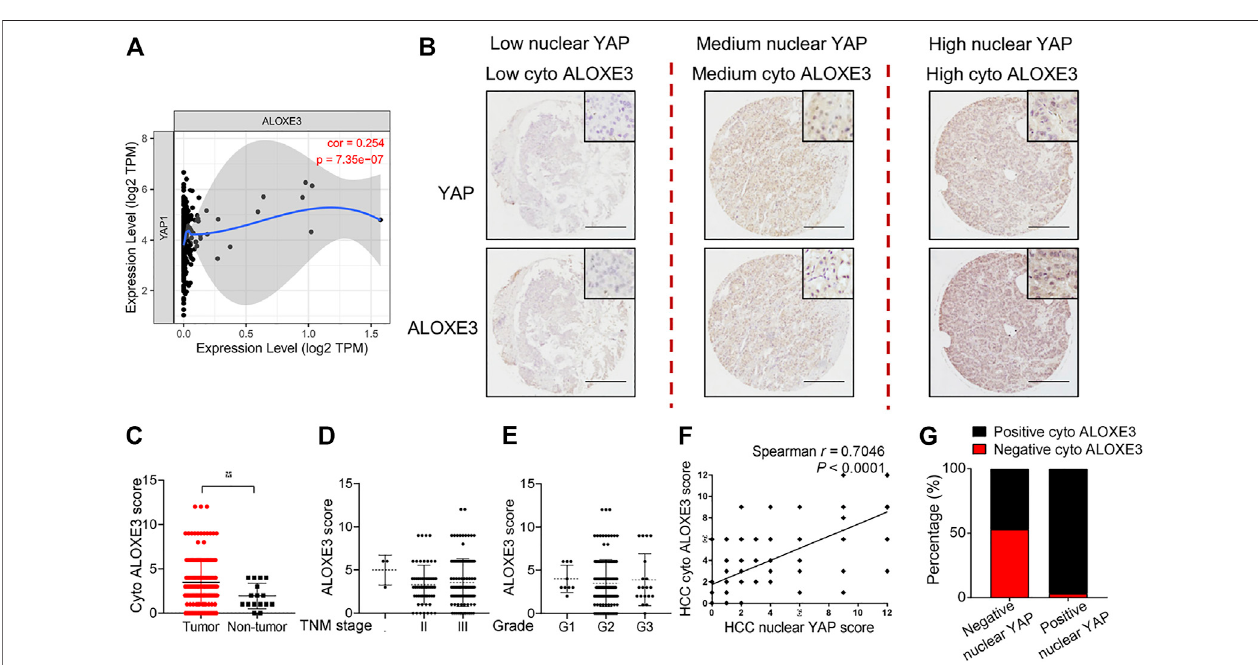
FIGURE 7 | The correlation of YAP with ALOXE3 in HCC. (A) The correlation between expression levels of YAP and ALOXE3 in HCC tissues were analyzed using the TIMER database. (B) Representative images of immunohistochemical staining of YAP and ALOXE3 in HCC tissues and normal liver tissue on tissue microarray sectionsareshown.Scalebars,200 μ m. (C) ExpressionscoresofALOXE3inHCCtissues( n (cid:2) 174)andnormallivertissue( n (cid:2) 16)assessedbyimmunohistochemistry. (D,E) ALOXE3expressionintumortissuesofHCCpatientswithdifferenttumorgradesorwithdifferentTNMclassi fi cation.I, n (cid:2) 3patients.II, n (cid:2) 61patients.III, n (cid:2) 110patients.G1, n (cid:2) 9patients.G2, n (cid:2) 140patients.G3, n (cid:2) 20patients. (F) PositivecorrelationbetweenthenuclearYAPscoreandtheALOXE3scoreinhumanHCC tissues ( n (cid:2) 174). (G) Percentage of tumors with positive or negative staining of nuclear YAP or ALOXE3.